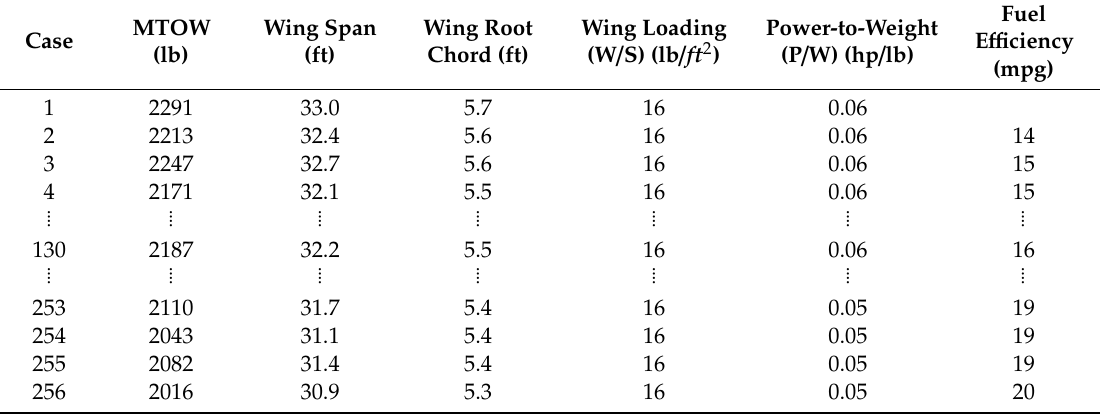
Table 4. Regression coefficients of a response surface model. Table 12. Factorial design result for applicable technologies.